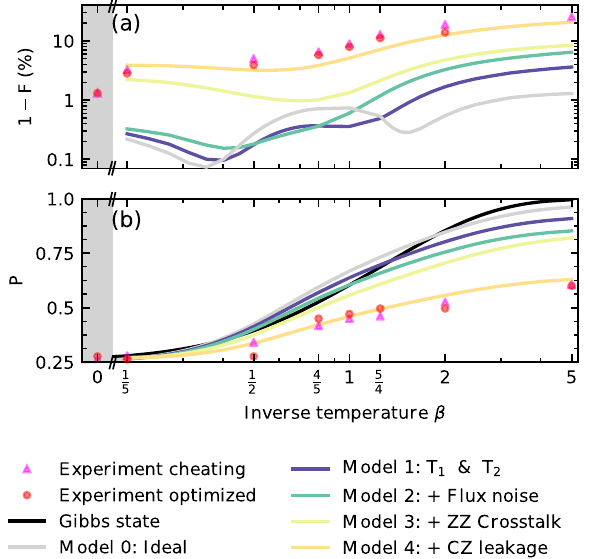
Fig. 5 Performance of the variational algorithm. a Fidelity to the Gibbs state as a function of inverse temperature β for experimental states obtained by optimization and cheating. b Purity of experi- mental states as a function of β , and comparison to the purity of the Gibbs state. Added curves in both panels are obtained by numerical simulation of a noisy quantum processor with incremental error models based on calibrated error sources for our device: qubit relaxation and dephasing times, increased dephasing from fl ux noise during CZ gates, residual ZZ crosstalk at the bias point, and leakage during CZ gates. Leakage is identi fi ed as the dominant error